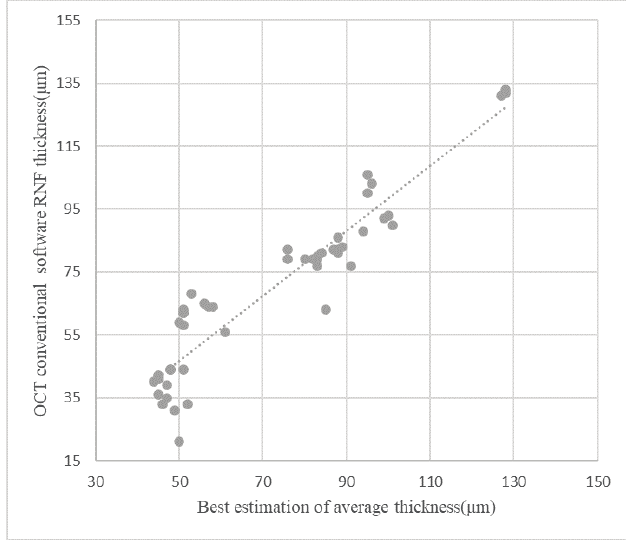
Figure 8. Scatterplot illustrating the relationship between the conventional OCT software and the best estimation thickness measurement by an expert for the test